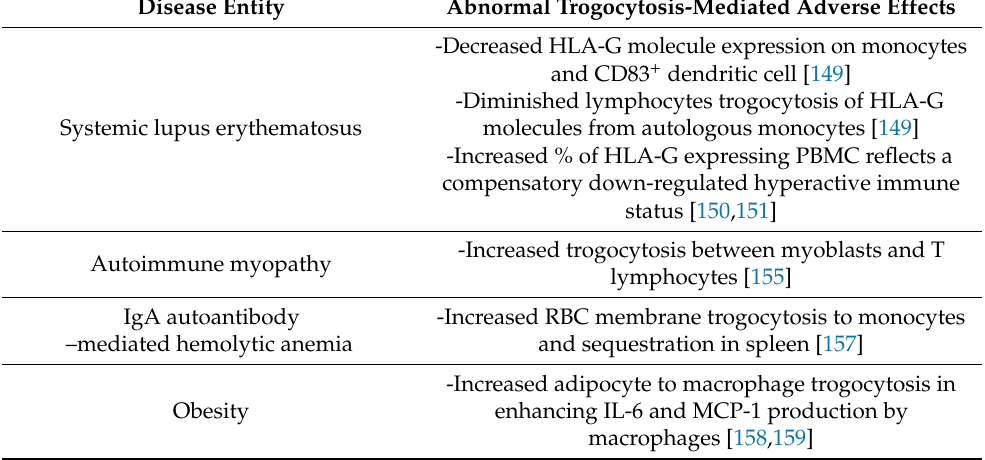
Table 1. Abnormal trogocytosis and the aberrant transferred molecules in patients with autoimmune, inflammatory diseases and